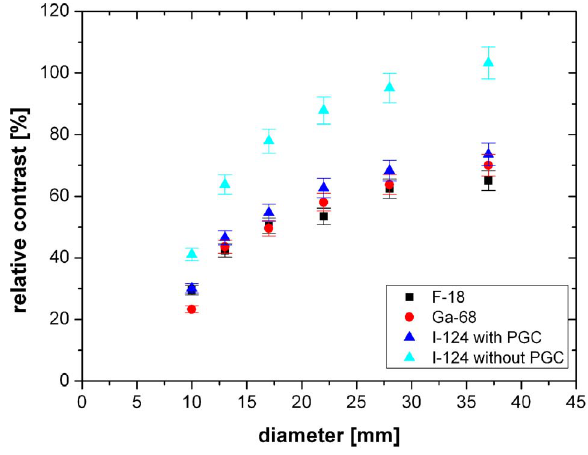
Figure 2. Relative contrast of F-18, Ga-68 and I-124 with and without PGC as a function of sphere diameter. Reconstruction iterative with scatter correction and a Gauss-filter with a FWHM of 2 mm and a S:BG < 10:1.